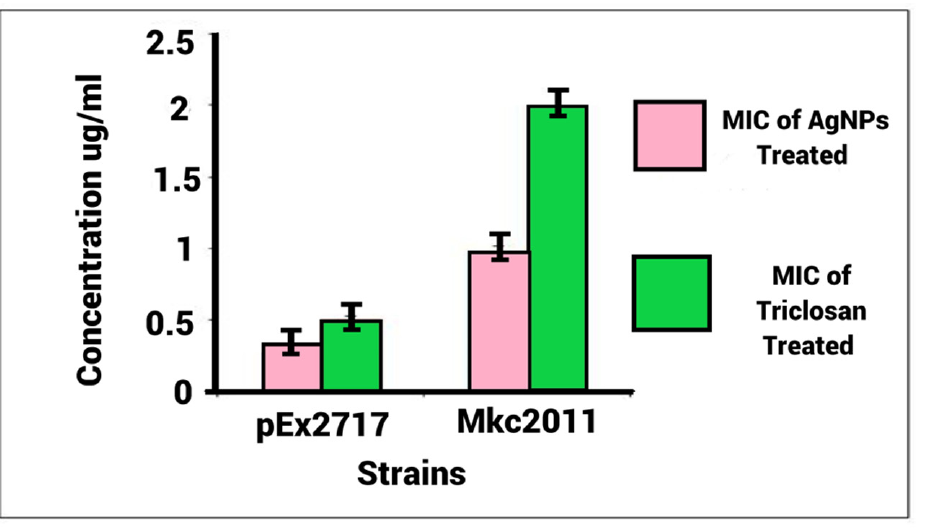
Figure 9. Minimum inhibitory concentration (MIC) of AC-AgNPs against Escherichia coli MTCC40 pEx2717 and Staphylococcus aureus MTCC 87 Mkv2011.